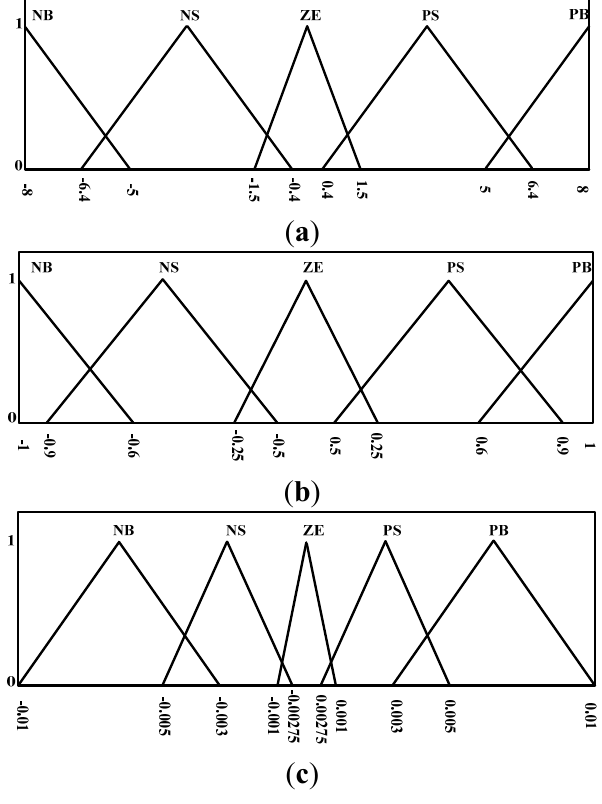
Figure 10. Membership functions for Algorithm (ii): ( a ). Membership function for P-V slope; ( b ) Membership function for changes of slope; ( c ). Membership function for increment of duty ratio